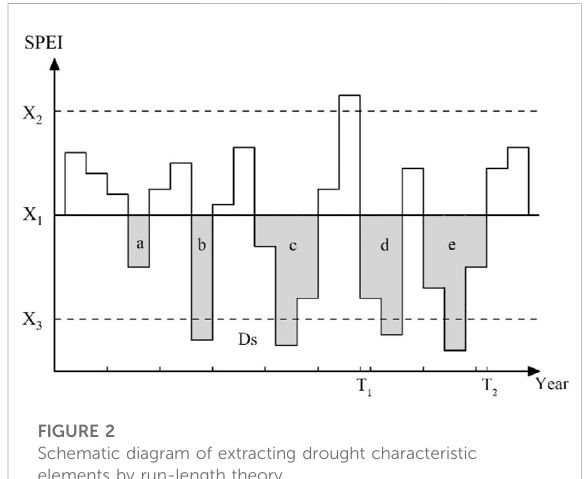
FIGURE 2 Schematic diagram of extracting drought characteristic elements by run-length